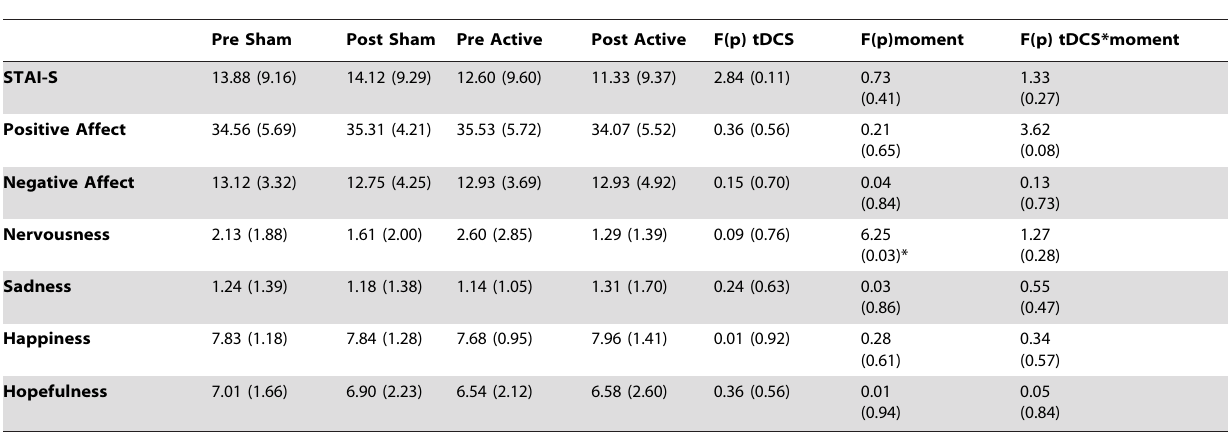
Table 2. Mean scores (and SD or p values) on mood variables (STAI, PANAS and VAS questionnaires).